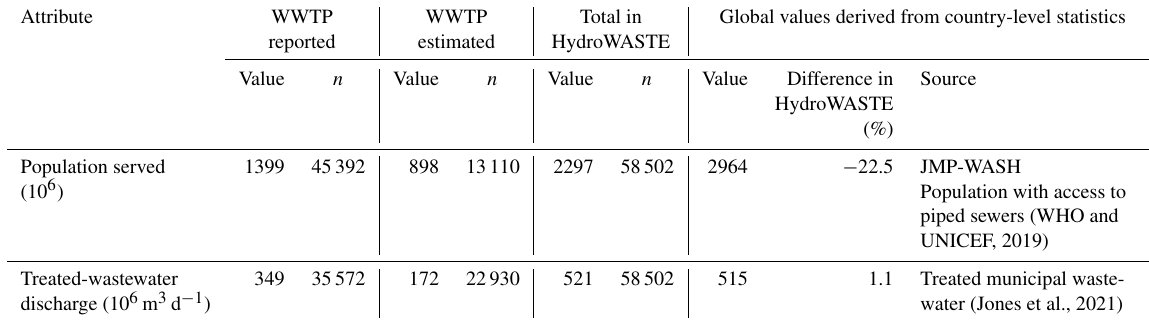
Table 4. Global treated-wastewater discharge and population served by WWTPs, according to HydroWASTE database and as provided by reported global values derived from country-level statistics. Reported WWTP data were provided by regional datasets (Table 1). Estimated WWTP data were derived using statistical methods (see Sect. 2.1.4). n is the number of WWTP records in